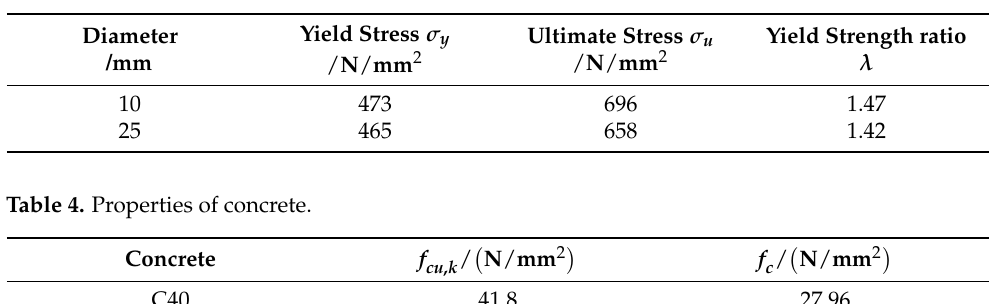
Table 3. Properties of reinforcement.